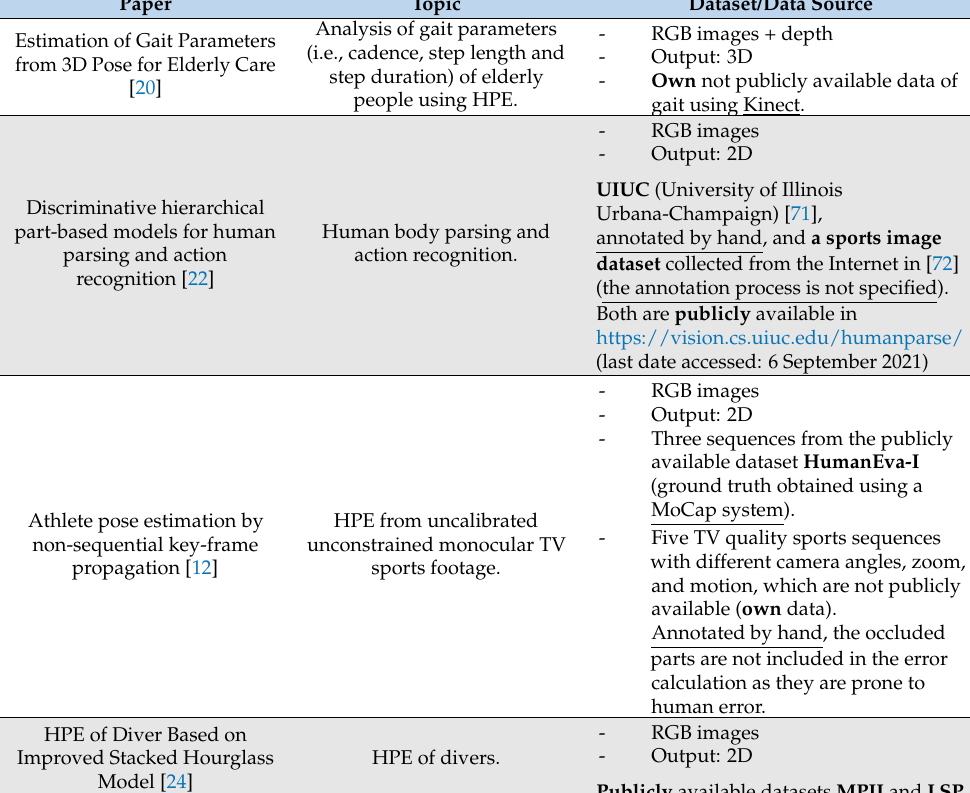
Table A4. Overall view of remarkable papers on the topic of HPE in SPE and the used